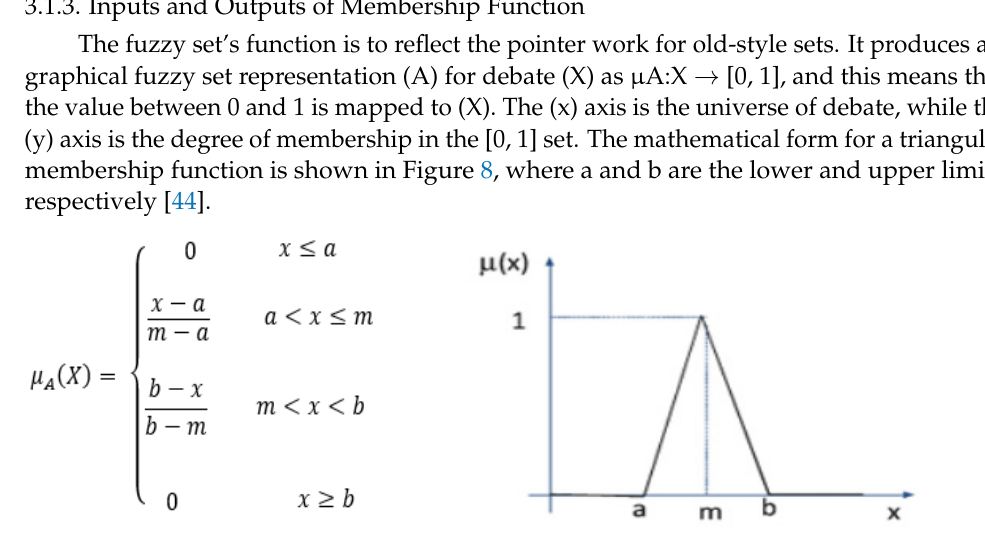
Figure 7. FSSW strength (static parameter) fuzzy logic control system ( a ) inputs and outputs ( b ) Mamdani FLCS.